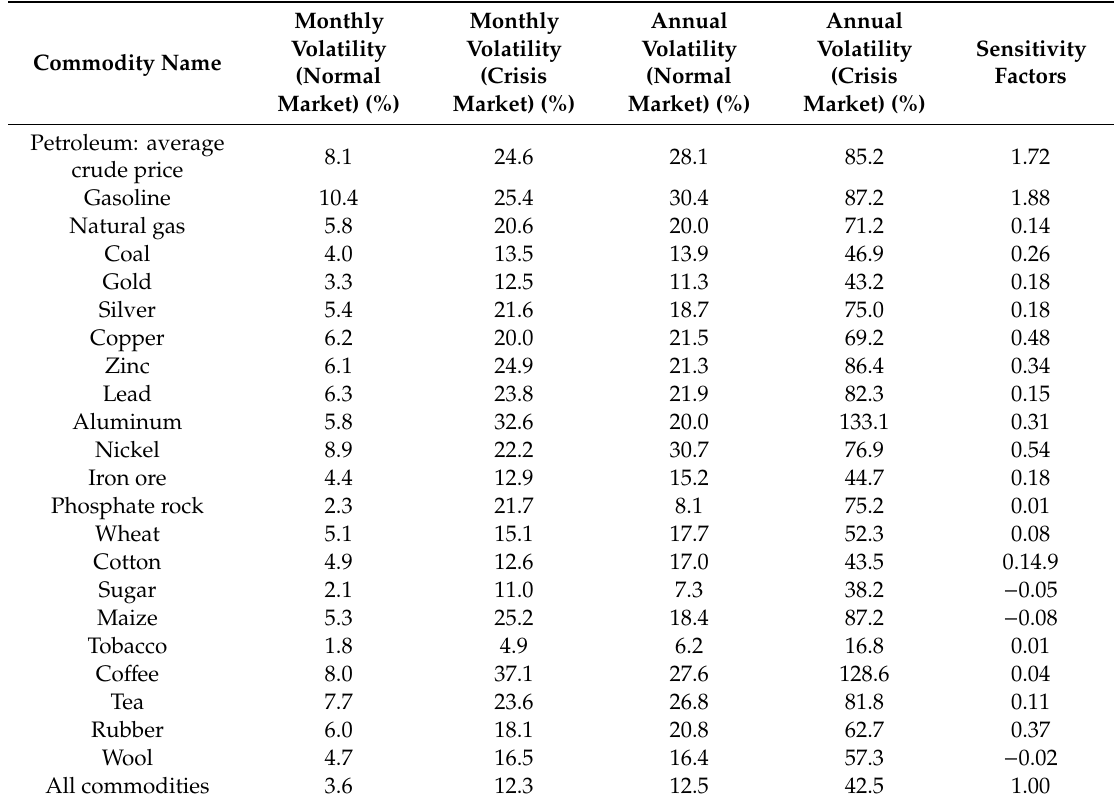
Table 1. Risk analysis data—volatility under normal and crisis market conditions and sensitivity factors (adapted from